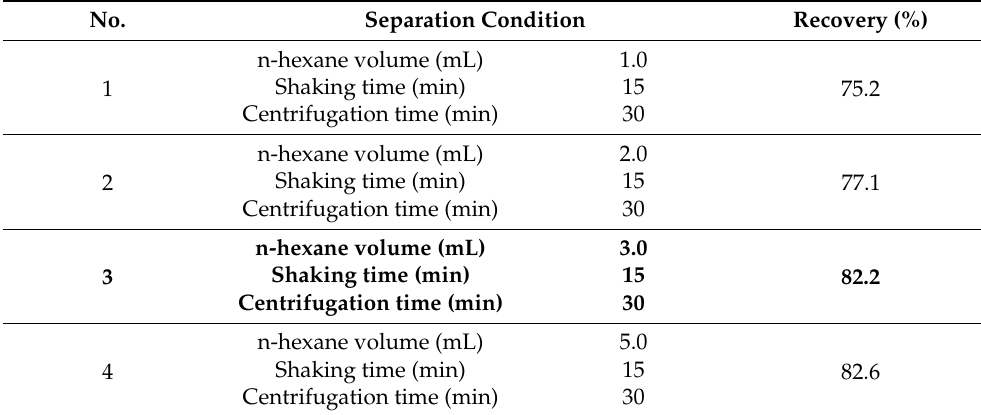
Table 2. Recovery of OND in the optimization of the sample preparation process.